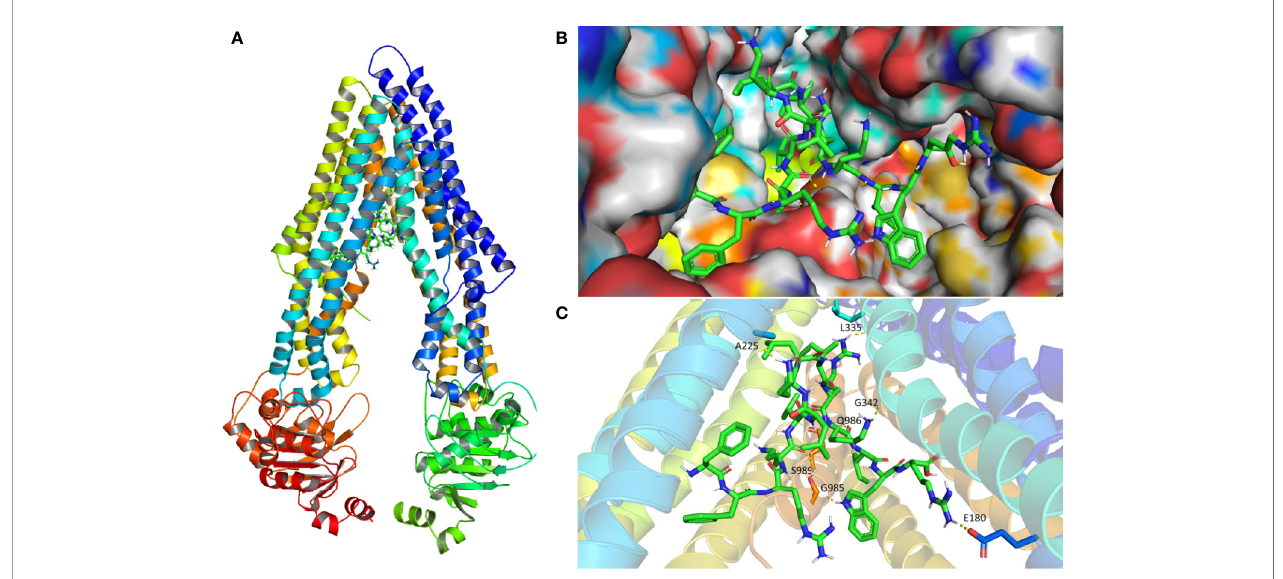
FIGURE 6 | Model structure showing the binding mode of peptide HX-12C to ABCB1. (A) Domains and positions of ABCB1 binding with peptide HX-12C. (B) Structures showing the surface of peptide HX-12C-ABCB1 complex. Peptide HX-12C is rendered in green. (C) The predicted binding mode of peptide HX-12C with ABCB1. The key residues interacting with peptide HX-12C are rendered as sticks. The hydrogen bonds are shown as yellow dotted